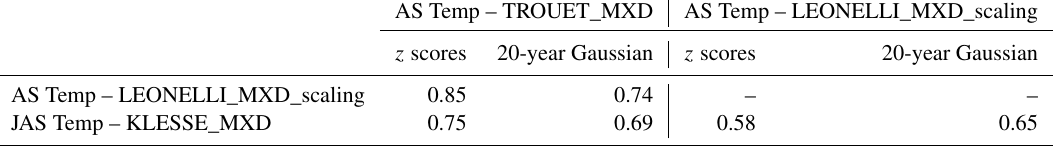
Table 4. Intercorrelation between reconstructed temperature series of late summer (AS; Trouet, 2014; Leonelli et al., this study) and of summer (JAS; Klesse et al., 2015) based on tree-ring MXD in the study region. The correlation coefficients were calculated over the common period 1714–1980, for both z scores and 20-year filtered